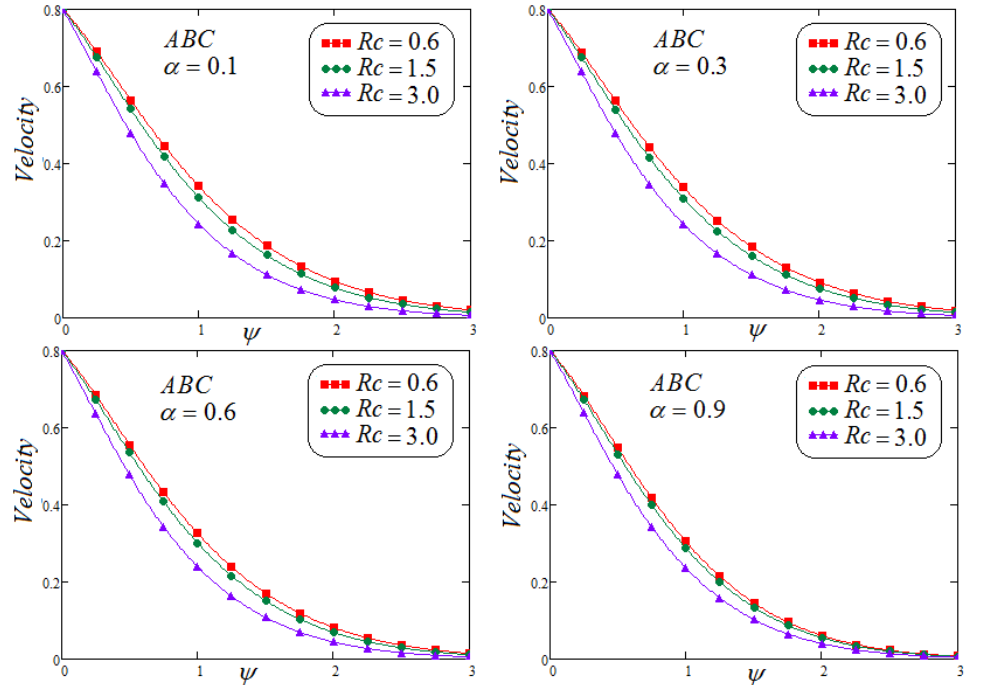
Figure 10. Trace of dimensionless velocity for dissimilar values of R c via